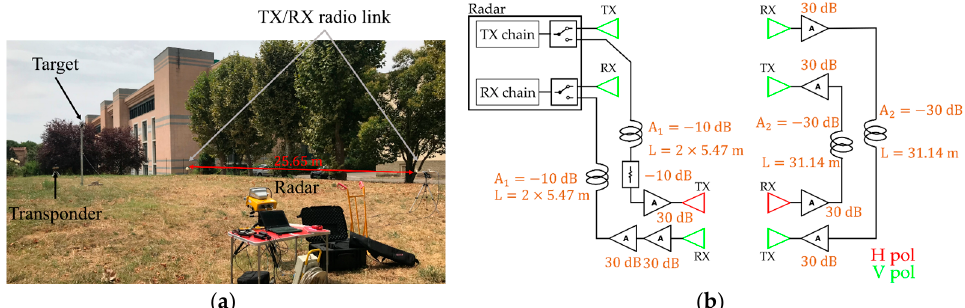
8 of 12 Figure 11. Natural frequency of target in Figure 7. 3.2. Test of multi-monostatic interferometric radar with radio link